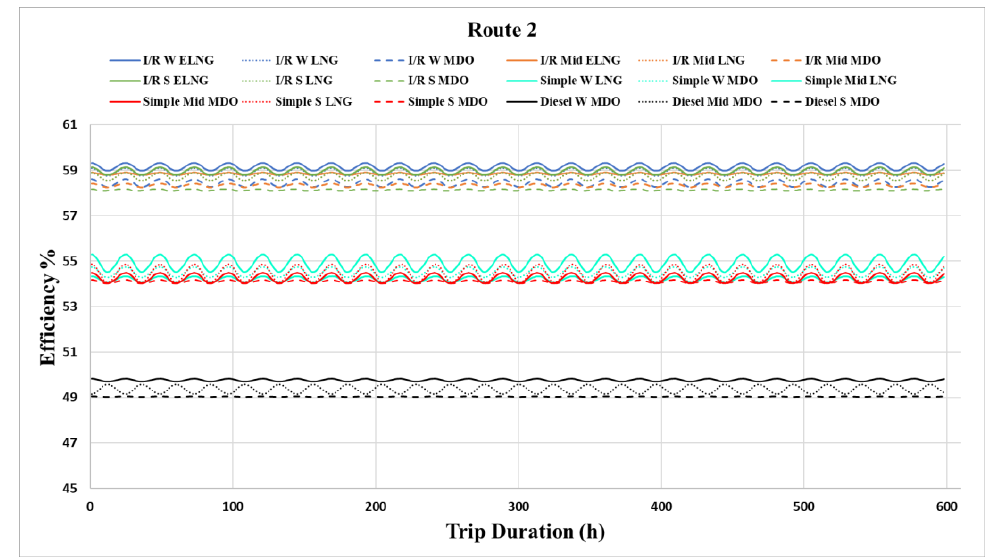
Figure 6. Performance of various propulsion systems of the large container ship travelling between Shanghai and Los Angeles. I/R: intercooler/reheater CCGT; S: simple CCGT; Diesel: two-stroke die- sel engine; W: winter; Mid: midseason; S: summer season; ELNG: enhanced liquified natural gas; MDO: marine diesel fuel; LNG: liquified natural gas.